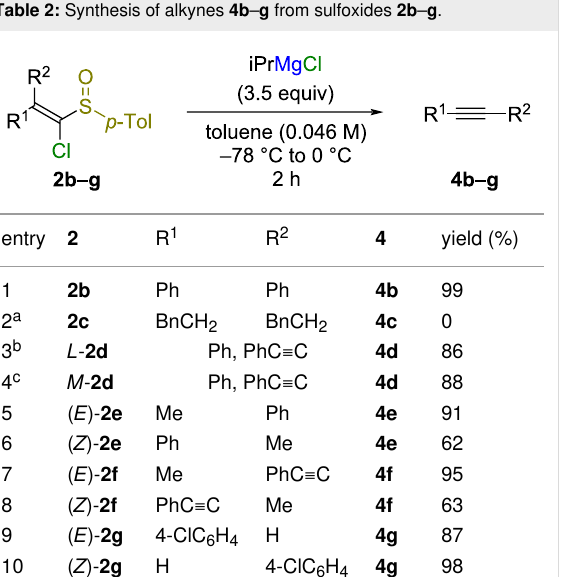
Table 2: Synthesis of alkynes 4b – g from sulfoxides 2b – g .